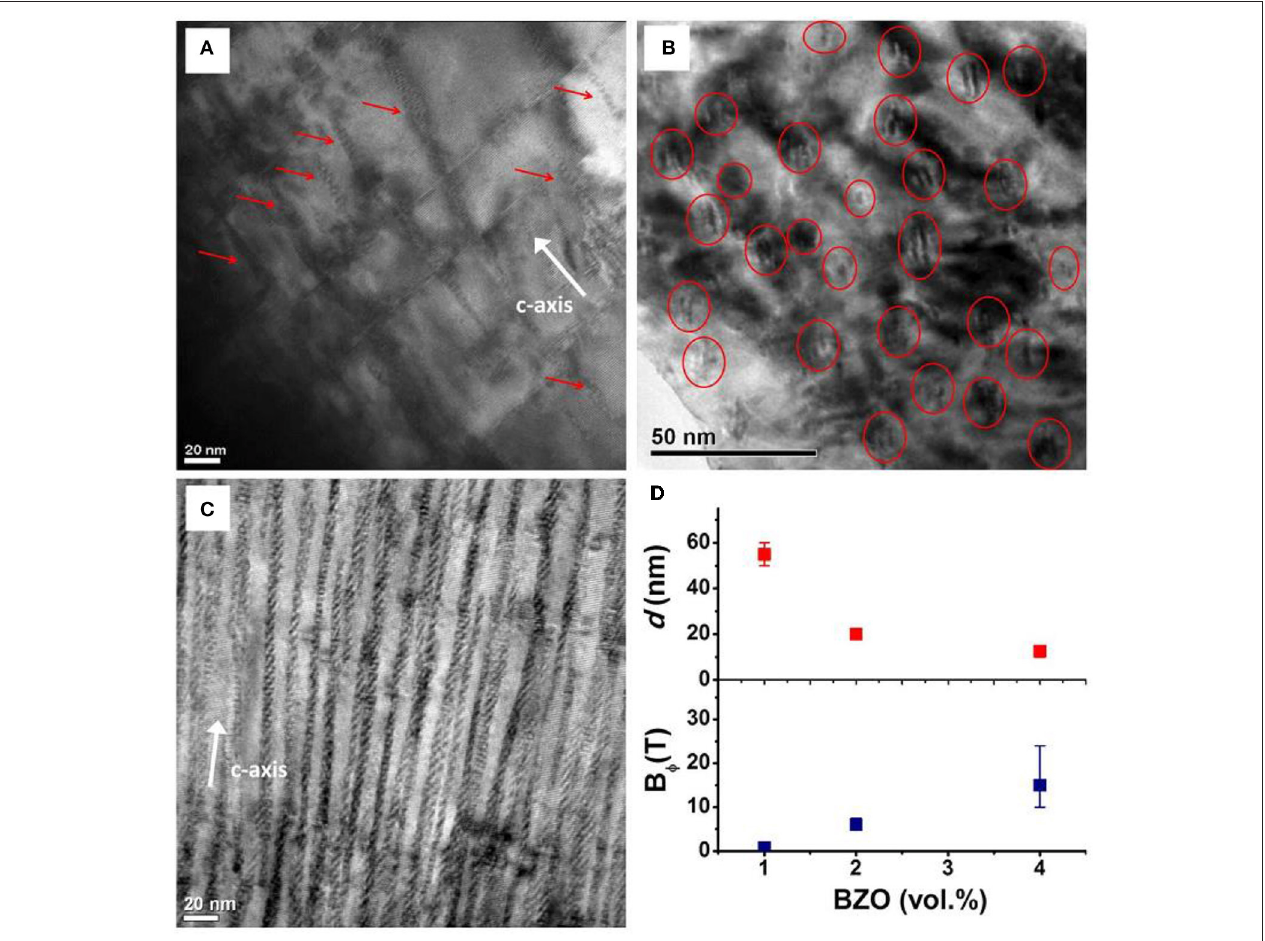
FIGURE 6 | Cross-sectional TEM images of (A) YBCO:BZO 1 vol% and (C) YBCO:BZO 4 vol% thin films. (B) Plan-view TEM image YBCO:BZO 2 vol% thin film. (D) The variation of average BZO nanocolumn spacing, d , and corresponding matching field, B ϕ , with BZO concentration. Reproduced from Wee et al.